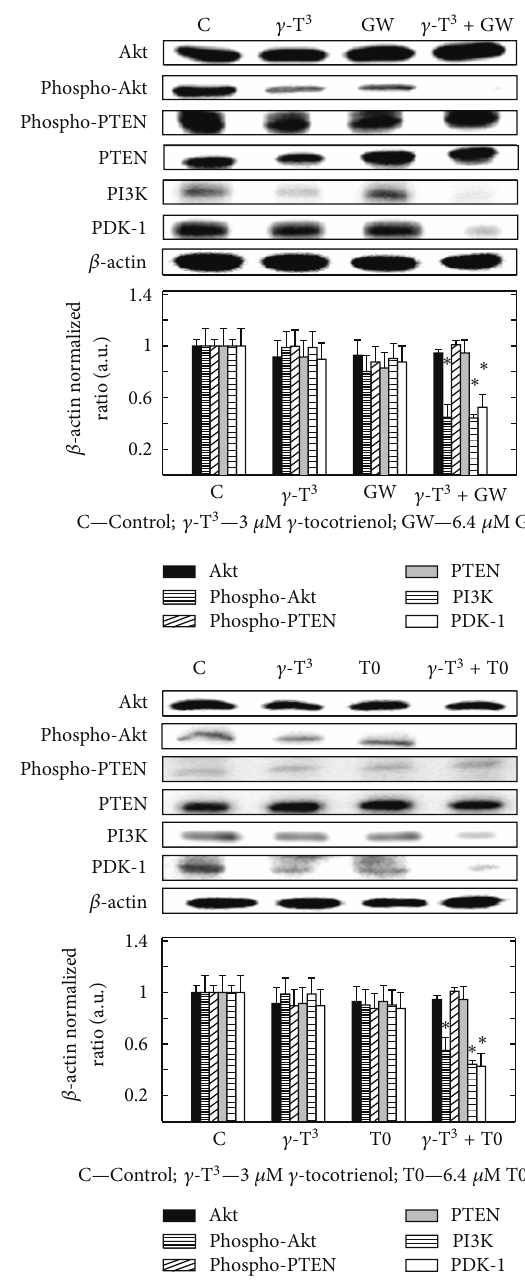
shown in bar graphs below their respective Western blot images. Vertical bars in the graph indicate the normalized integrated optical density of bands visualized in each lane